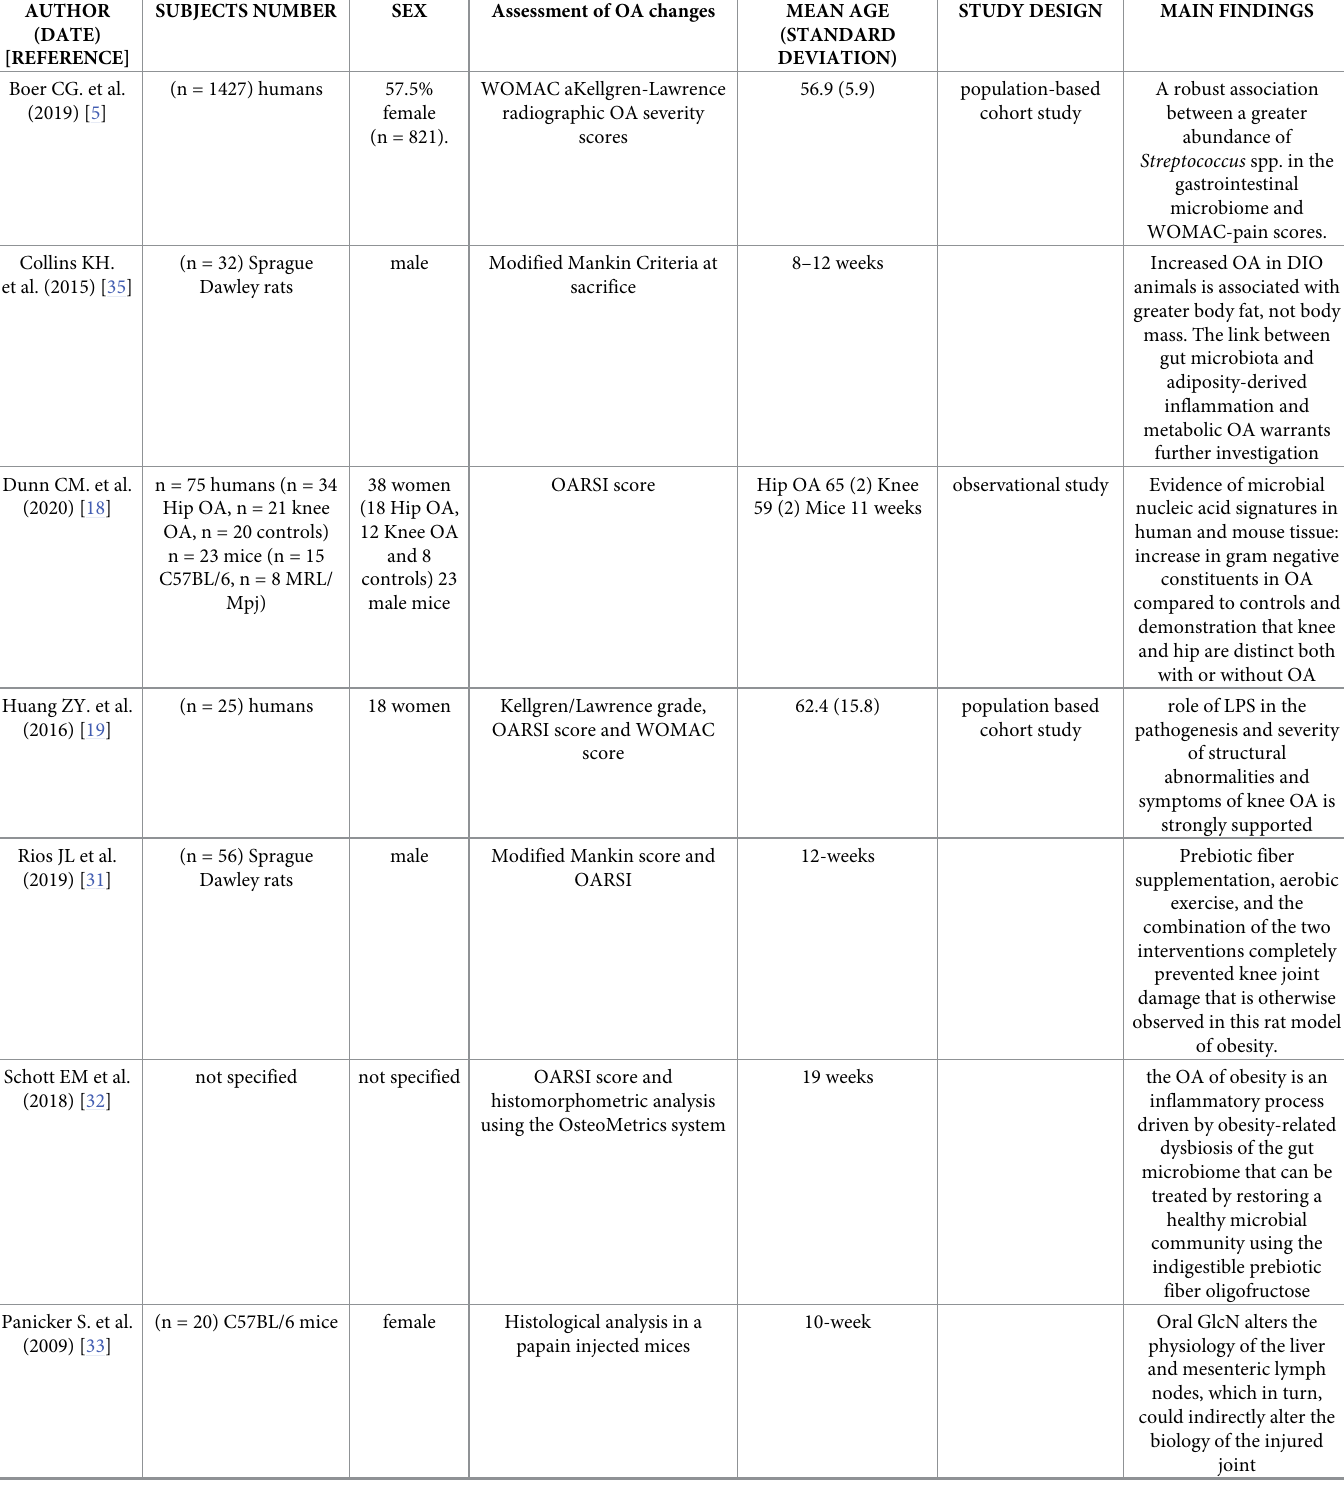
Table 1. The main findings of the included